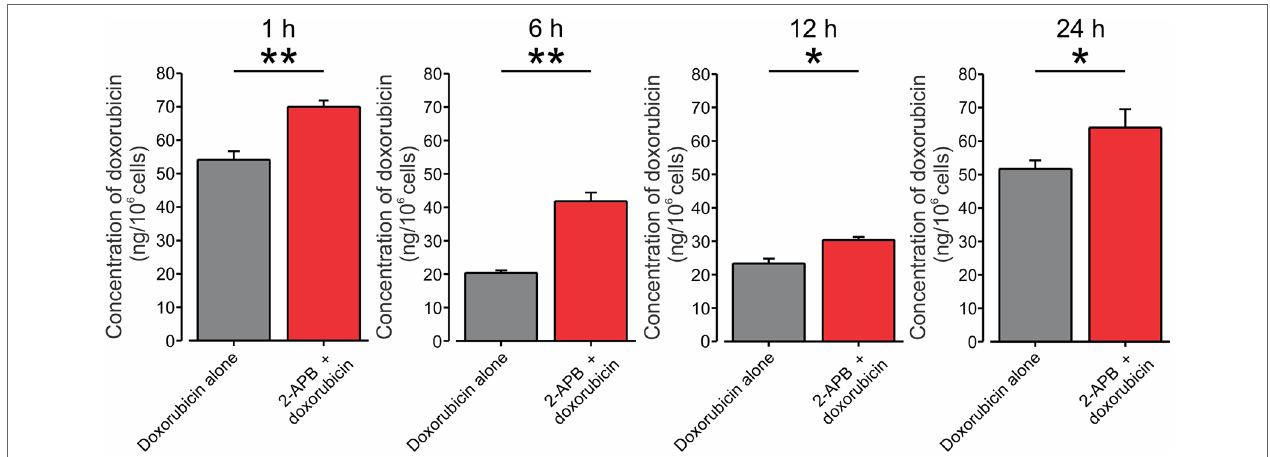
FIGURE 4 | Co-application of doxorubicin with 2-APB leads to an increased amount of intracellular doxorubicin in BNL1 ME cells. Bar graphs depicting the amount of doxorubicin in BNL1 ME cells (in ng/10 6 cells) measured using fluorometric analysis, 1, 6, 12, and 24 h following treatment with 1 µM doxorubicin alone ( gray ) or with 1 µM doxorubicin co-applied with 200 µM 2-APB ( red ). Note that the amount of intracellular doxorubicin was significantly increased when doxorubicin was co-applied together with 2-APB, *—p < 0.05, **—p < 0.01, Student’s t -test, n = 3 repetitions for 1-, 6-, and 12-h time points, n = 2 repetitions for 24-h time point, n = 3 repetitions, for each treatment